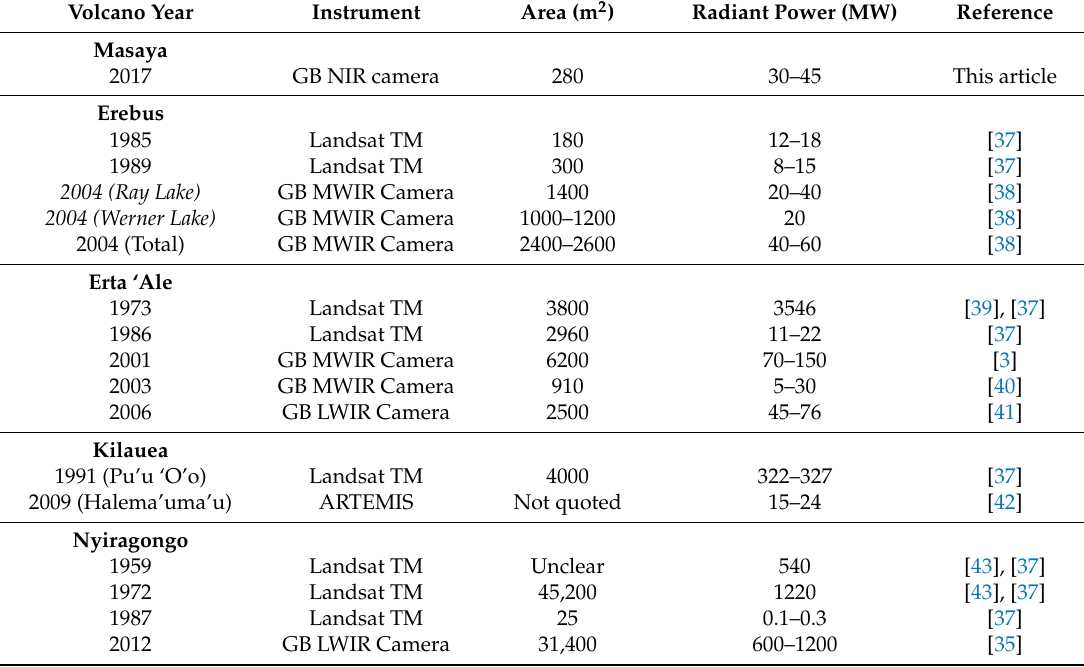
Table 2. Assimilation of lava lake radiant power data, associated lake areas and the instrument used for the retrieval. Only relatively high-resolution instruments are included here, such that studies which calculate radiant power from sub-pixel scale lava lakes are omitted.